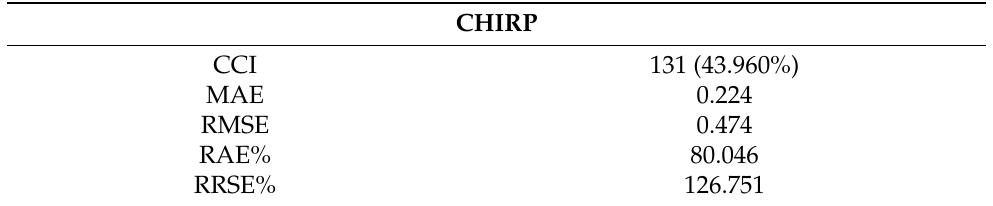
Table 11. CCI and Error Rates details achieved via CHIRP.